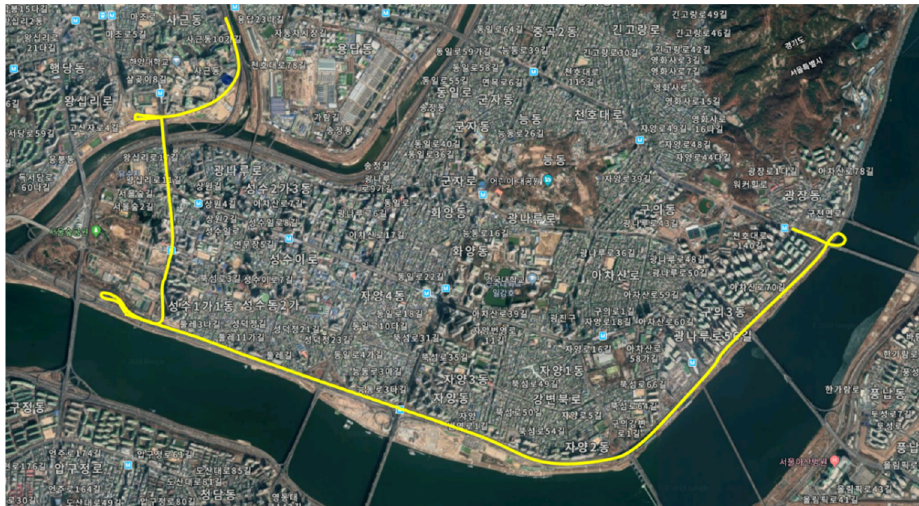
Figure 14. Route for vehicle test.